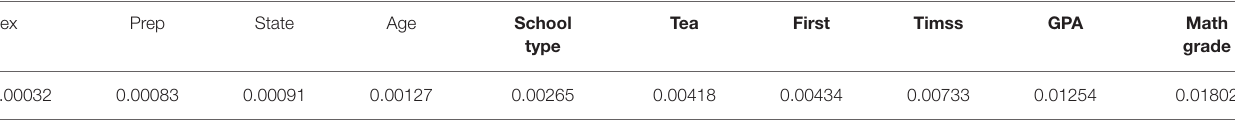
TABLE 5 | Sorted list of the conditional variable importance for the conditional forest and the feature selection used in further analysis. Sex Prep State Age